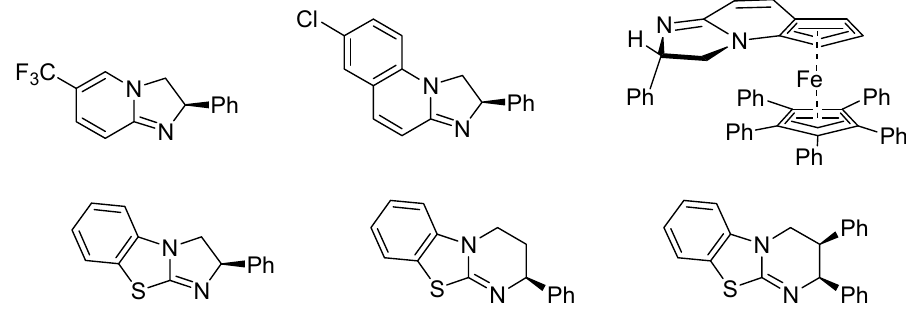
Figure 8. Catalysts for enantioselective acyl transfers.